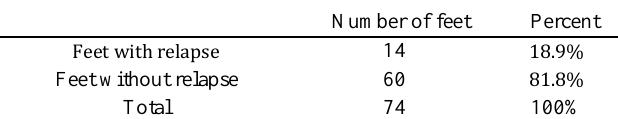
Table 3: feet with and without relapse: